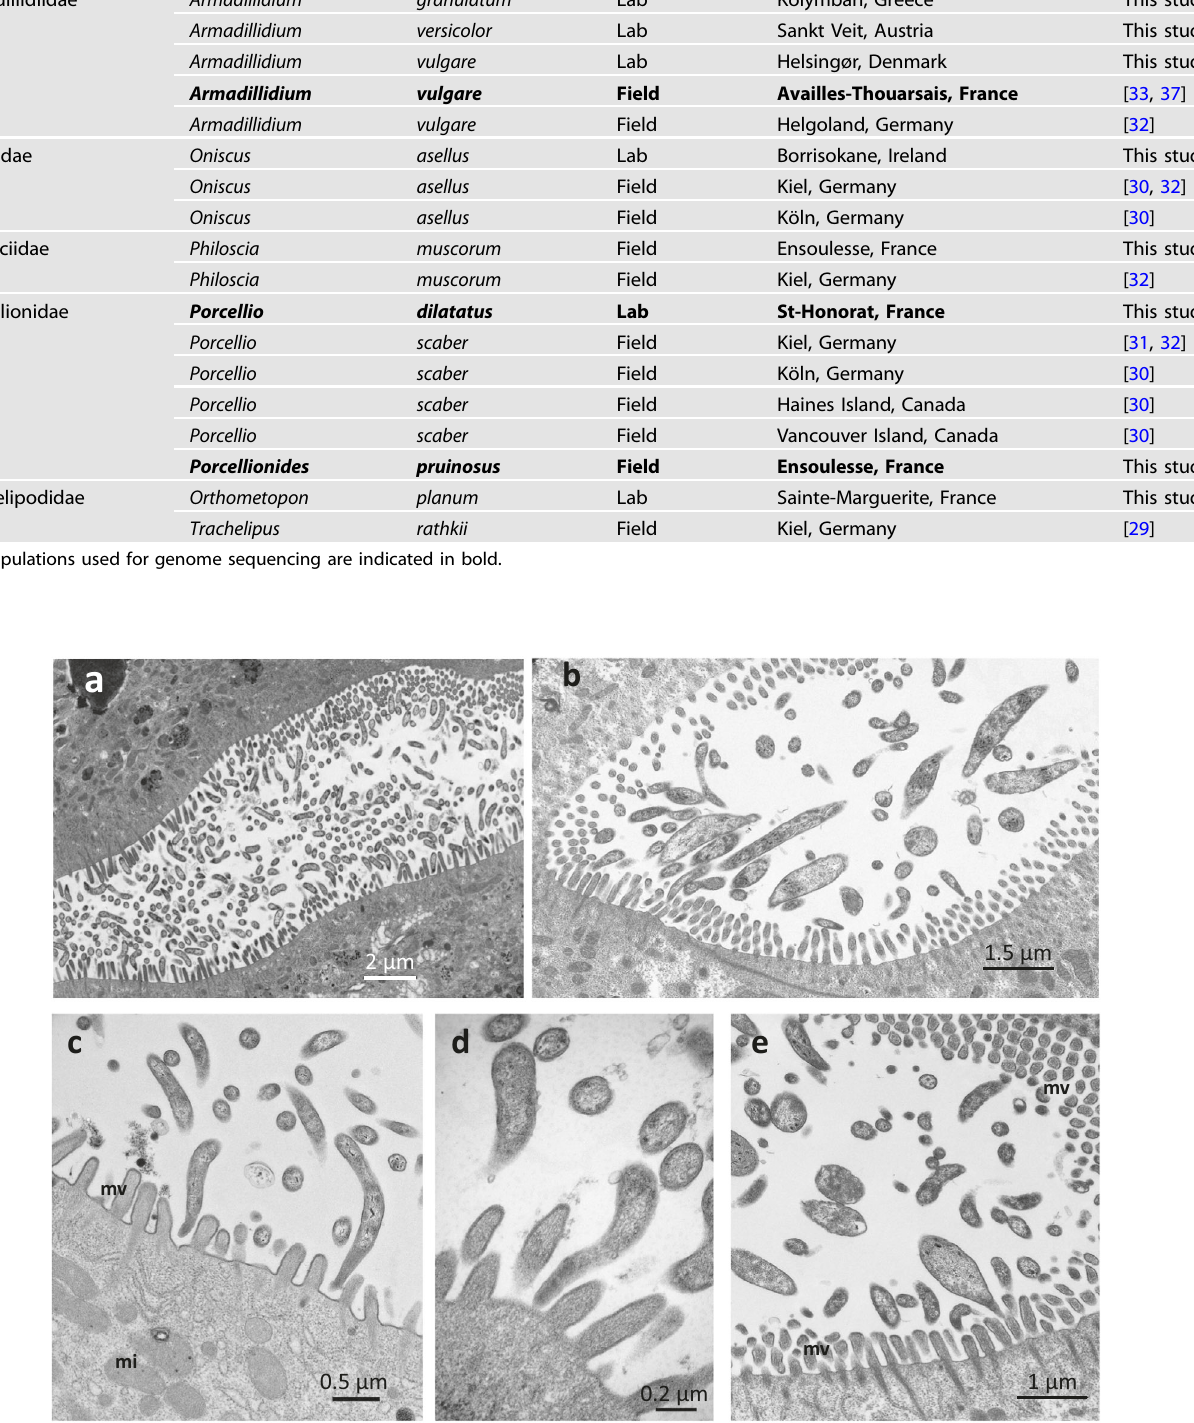
Table 1. Terrestrial isopod species tested positive for Hepatincola .